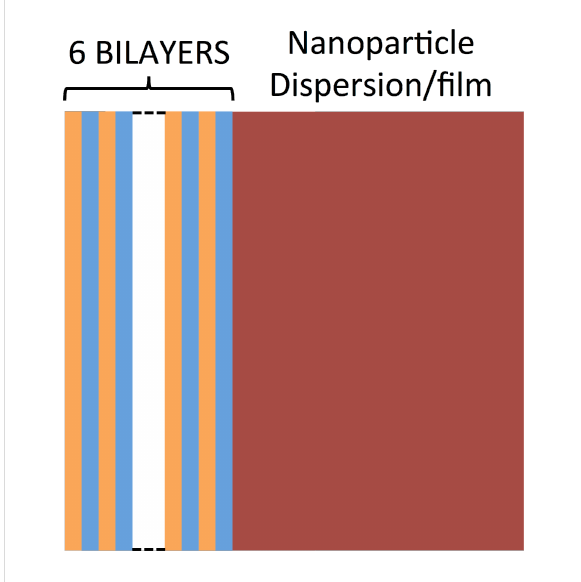
Figure 1: Scheme of the device in which a Bragg mirror (photonic crystal), illustrated by alternating orange and blue layers, is coupled to a dispersion of Cu 2 − x Se NCs in toluene or an ITO NC film (dark red) to act as a tunable light filter. In the presented device, tunability is envis- aged upon the modulation of the carrier density in the heavily doped semiconductor NC component through chemical and electrochemical treatments, ultimately leading to tunable plasmonic light absorption.